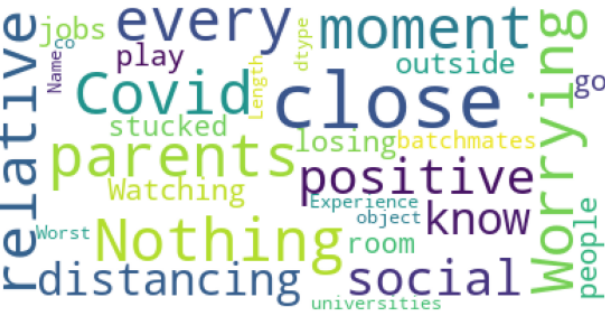
Figure 8. Word cloud representation of worst